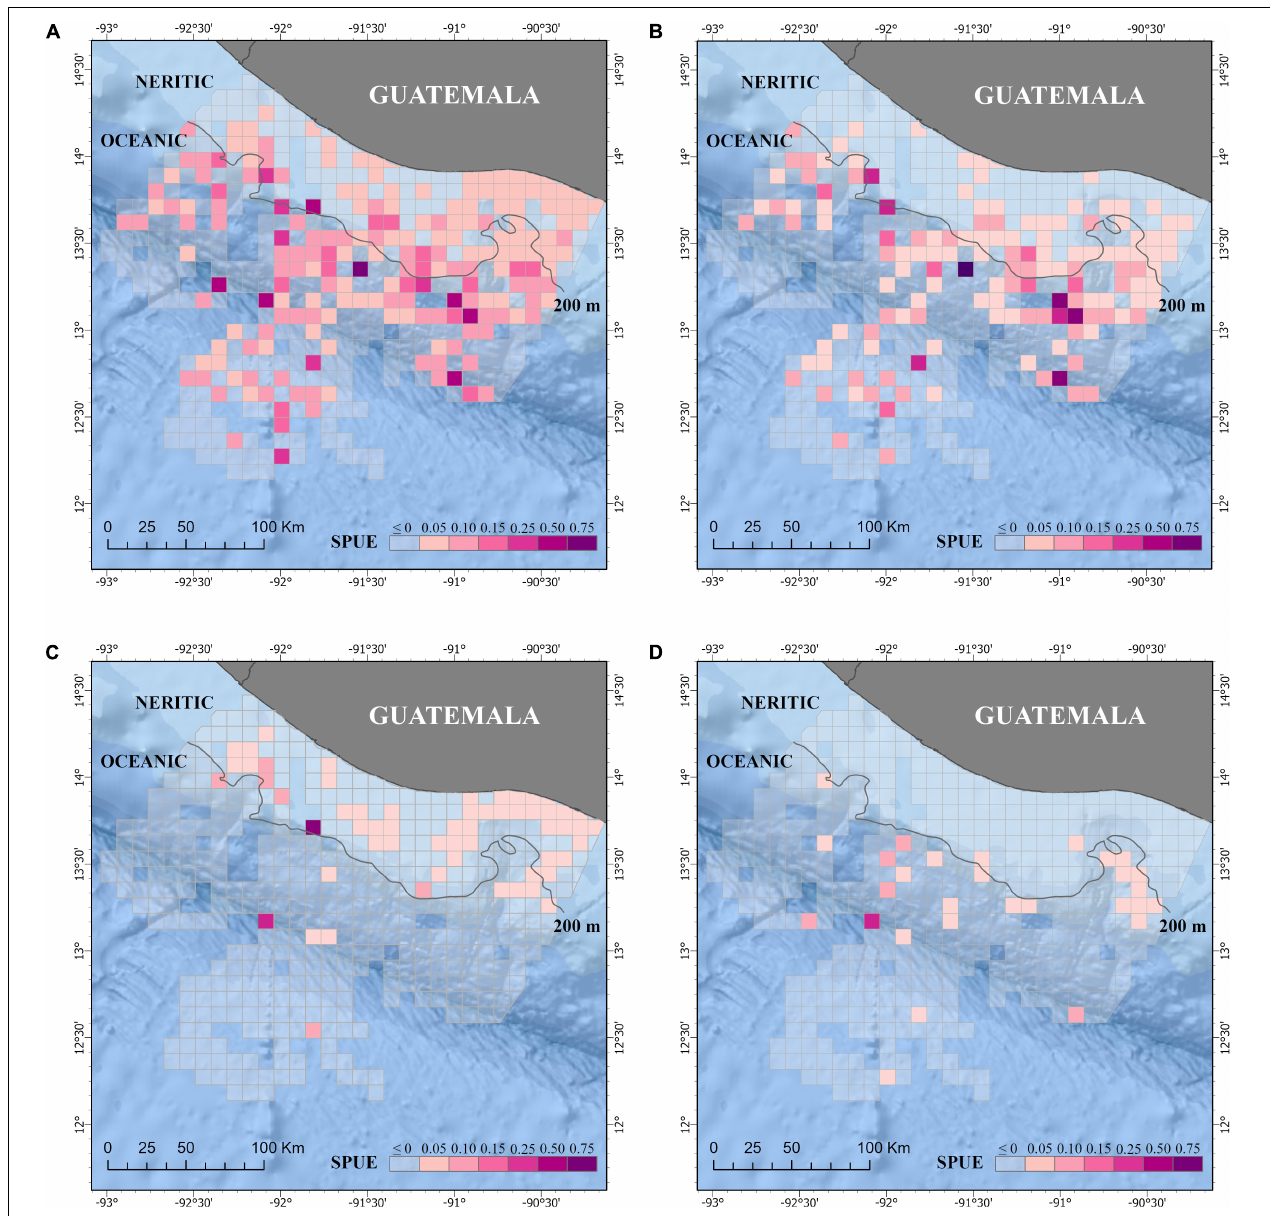
FIGURE 4 | Sightings per unit effort (SPUE) of all cetacean species (A) and the three most common species: (B) Tursiops truncatus , (C) Stenella attenuata , and (D) Stenella longirostris in the Pacific waters of Guatemala. Effort is km of survey summarized by 10 km × 10 km grid cells. Neritic ( < 200 m depth) and ocean ( > 200 m depth) zones are also included. Additional details of the study area are shown in Figure 1